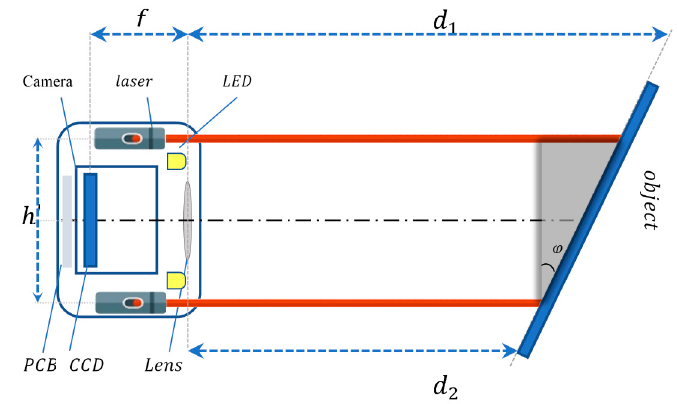
Figure 3. Yaw ( φ (cid:2935)(cid:2911)(cid:2933) ) and pitch ( φ (cid:2926)(cid:2919)(cid:2930)(cid:2913)(cid:2918) ) angle determination.